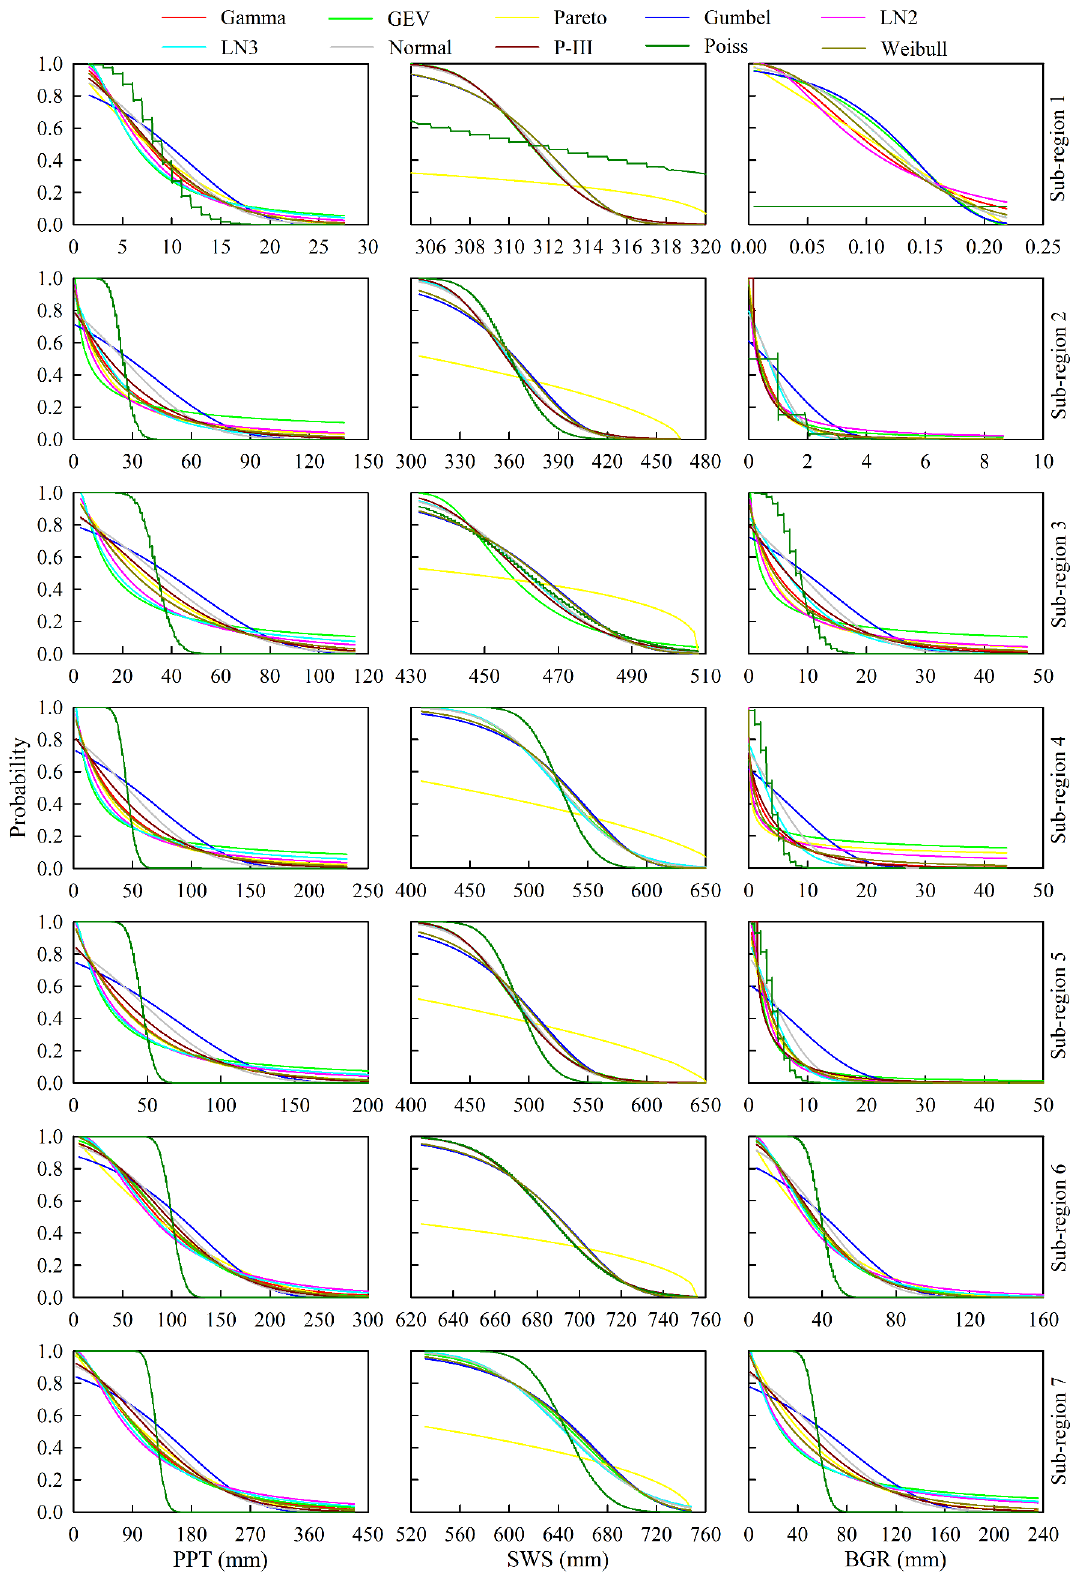
Figure A1. The curves of the 10 PDFs for PPT, BGR, and SWS in seven different subregions of China.